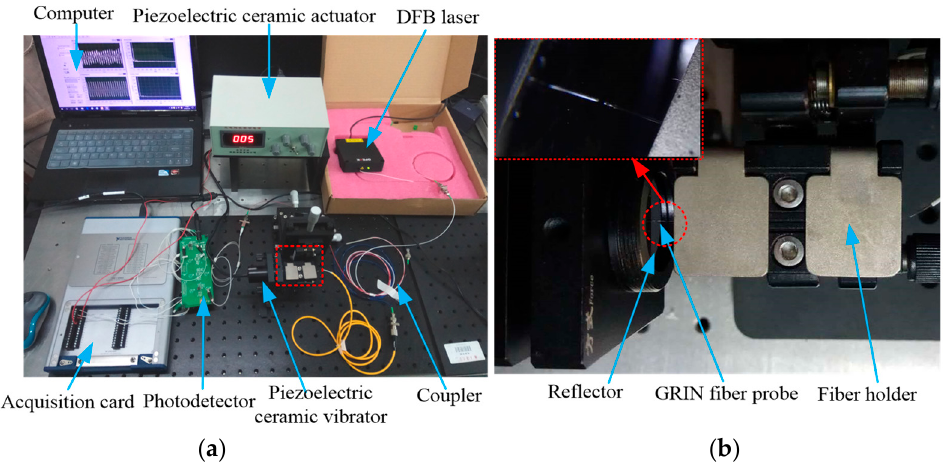
Figure 5. The F–P interferometer experimental system based on the ultra-small GRIN fiber optic probe: ( a ) picture of the experimental system; ( b ) a more detailed picture of the experimental system; ( b ) a larger view of the red dashed square from ( a ).